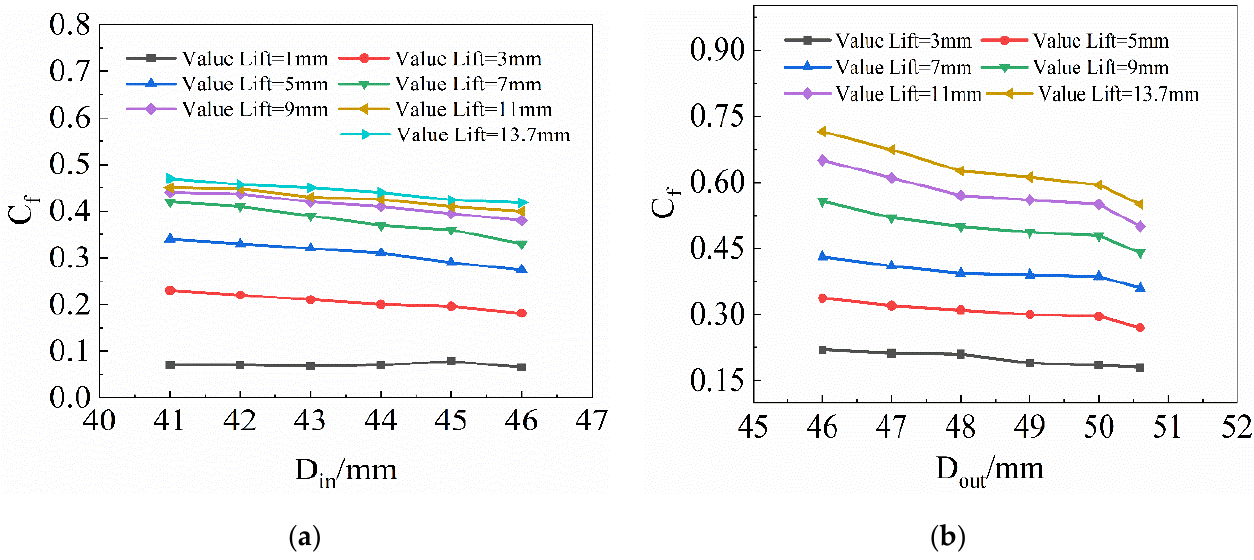
Figure 7. ( a ) Test results of different throat intake ports; ( b ) test results of different throat exhaust port.